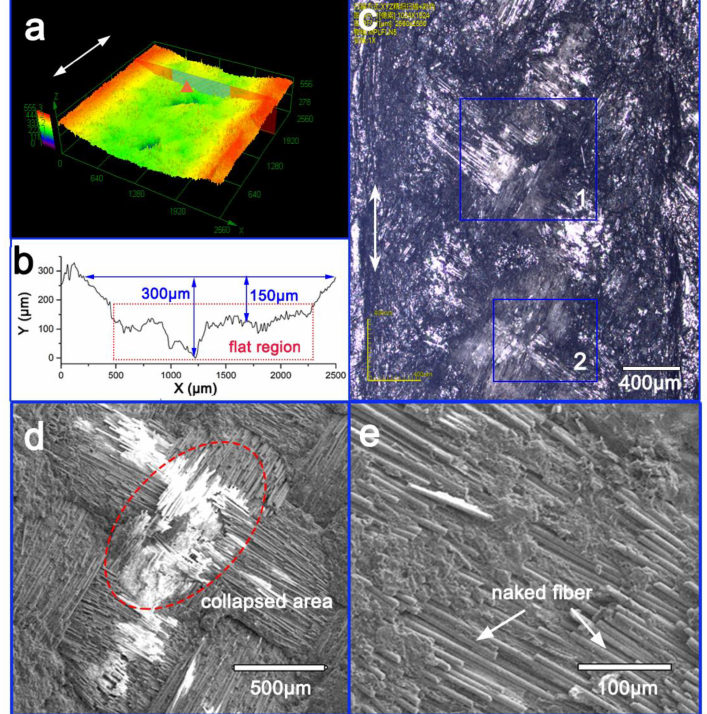
Figure 9. Morphology of worn surface of B-0.4 g: ( a ) 3D surface topography, ( b ) surface profile, ( c ) optical image of worn surface, ( d,e ) enlarged SEM images of Sections 1 and 2 from Figure